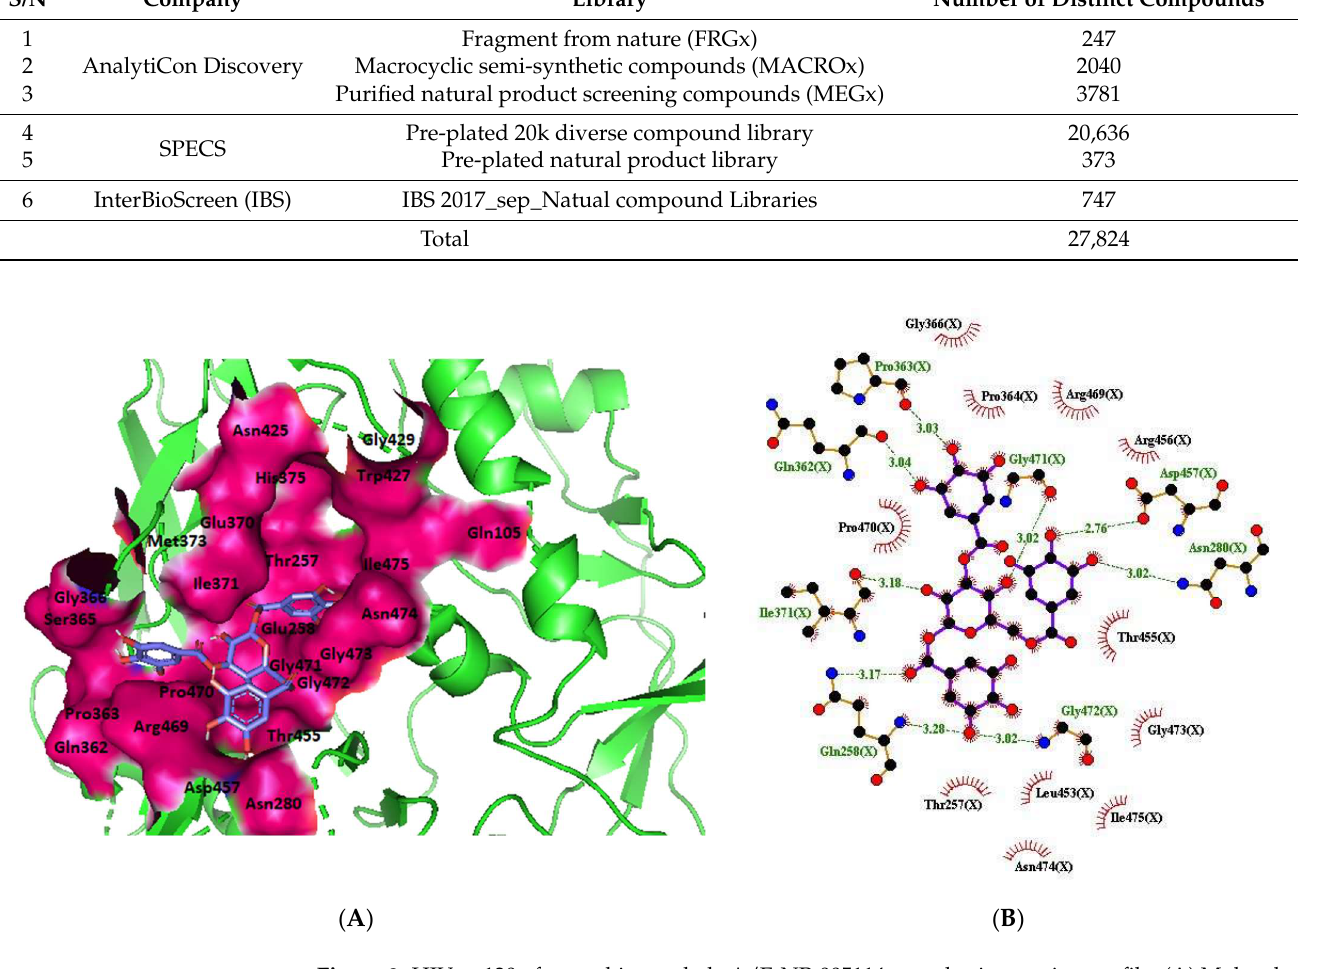
Figure 3. HIV gp120 of recombinant clade A/E-NP-005114 complex interaction profile. ( A ) Molecular representation of HIV gp120 of recombinant clade A/E in complex with compound NP-005114 (represented as sticks, firmly docked into CD4-bs (colored hot pink) of HIV gp120). ( B ) Protein– ligand interaction profile evaluated using LIGPLOT. In ( B ), the green dotted lines represent hydrogen bond interactions, while red arcs with spikes represent hydrophobic interactions. Residues of the receptor are shown as orange lines with black and red dots, while the ligand is shown as purple lines with black and red dots. Ligand NP-005114 had 9 hydrogen bonds and 11 hydropho- bic bonds with residues in the CD4-bs of HIV gp120. Table 2. Binding energies and interacting amino acid residues of recombinant clade A/E and clade B HIV-1 gp120.